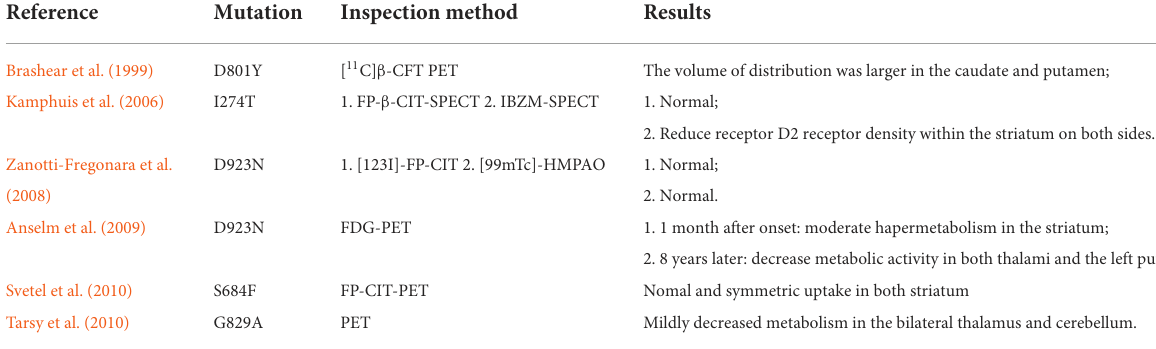
TABLE 3 Summary of molecular imaging findings on RDP and intermediate AHC/RDP.